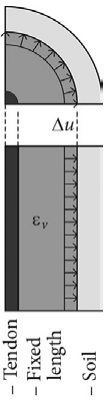
Fig. 9. Consideration of high-pressure grouting in the Finite Element